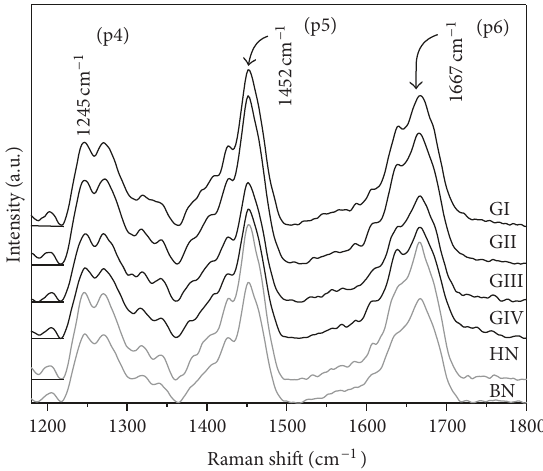
F 2: Comparison of FT-Raman spectra of organic components from normal bovine dentin (BN) and normal human dentin (HN); human dentin treated with Xeno III (GI) and Prime & Bond 2.1 (GII) adhesives; bovine dentin treated with Xeno III (GIII) and Prime & Bond 2.1 adhesives